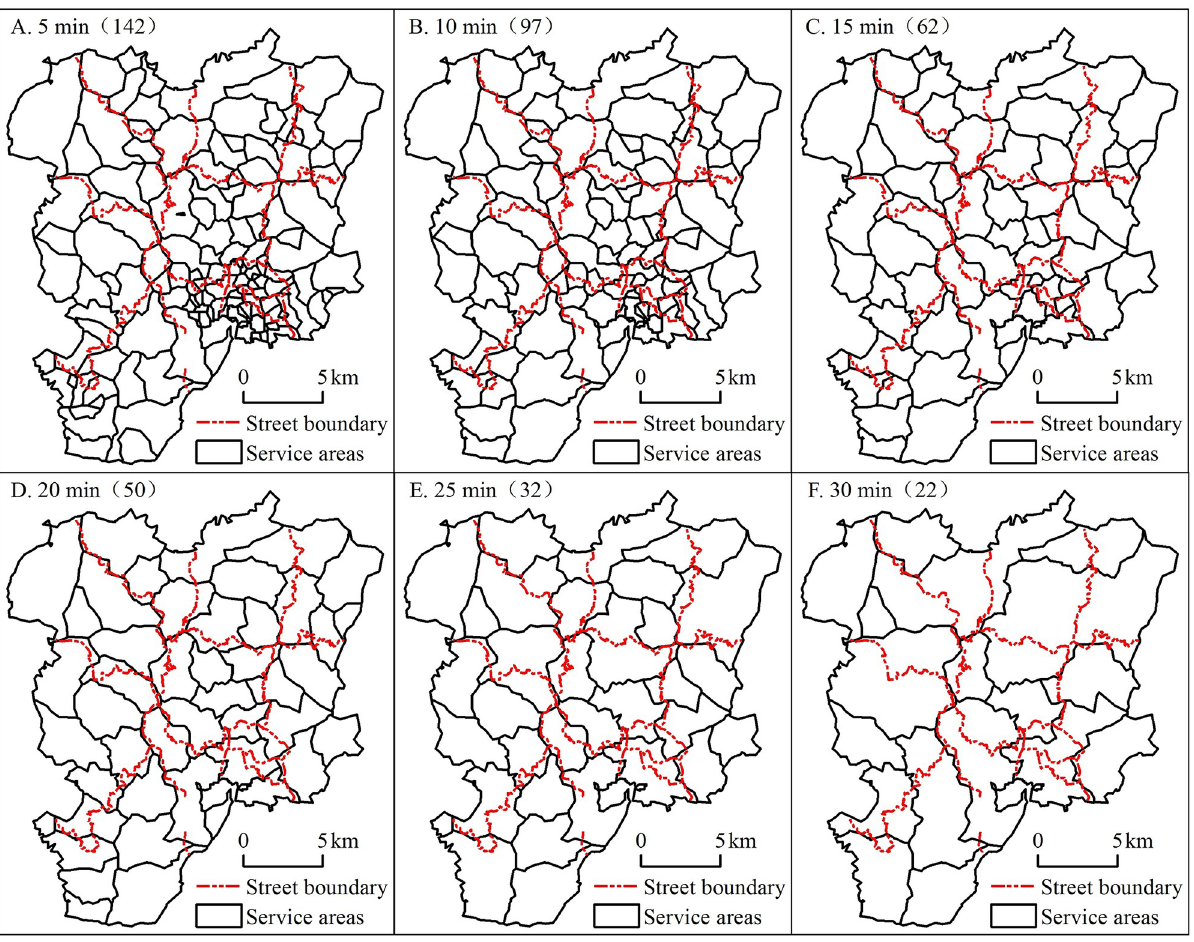
Fig 3. Tourist attractions service range integration